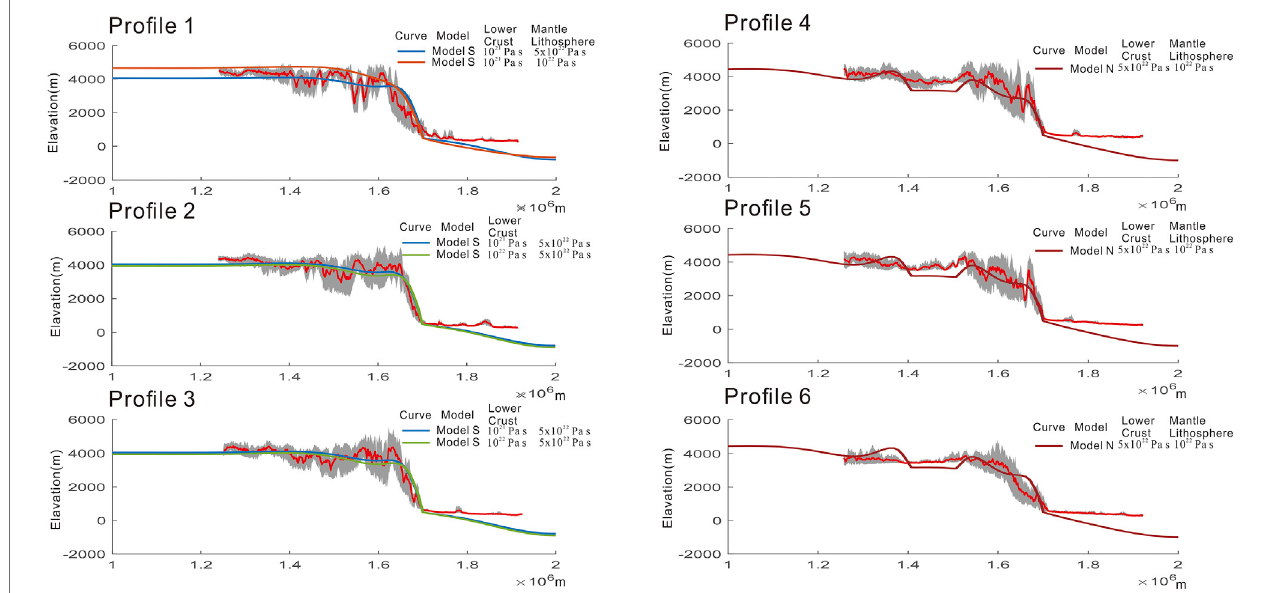
FIGURE6| Best fi ttingresultfromthecomparisonbetweenthesimulationresultsandDEMextractionresults.Pro fi les1,2,and3aretheresultsofModelSmerged withtheextractedDEMpro fi les1-1 ′ ,2-2 ′ ,and3-3 ′ ,respectively.Pro fi les4,5,and6aretheresultsofModelNmergedwiththeextractedDEMpro fi les4-4 ′ ,5-5 ′ ,and6- 6 ′ , respectively. In the legend exhibits different the viscosity of lower crust and mantle lithosphere in the Tibet Plateau.